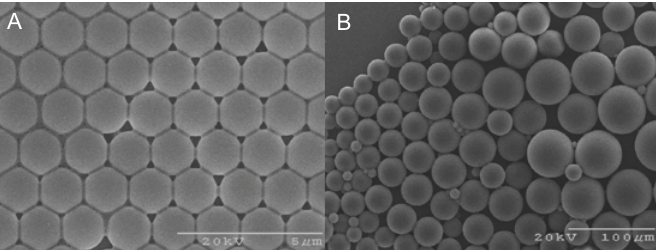
Figure 3. Scanning electron microscopic images of polystyrene particles prepared by (A) one-batch reverse ATRP and (B) two-stage reverse ATRP, respectively [123]. Reproduced with permission from the American Chemical